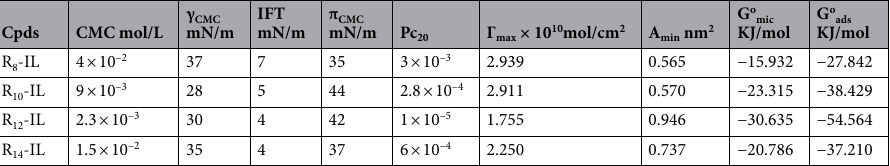
Table 7. Surface active parameters of the prepared ILs.